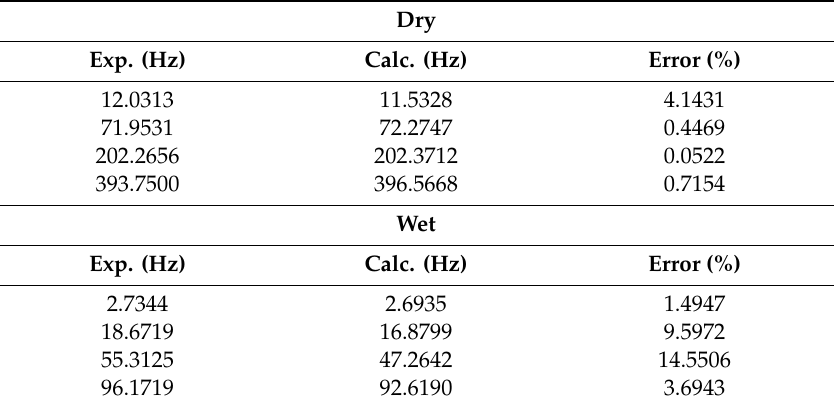
Table 1. Natural frequencies from analytical and experimental